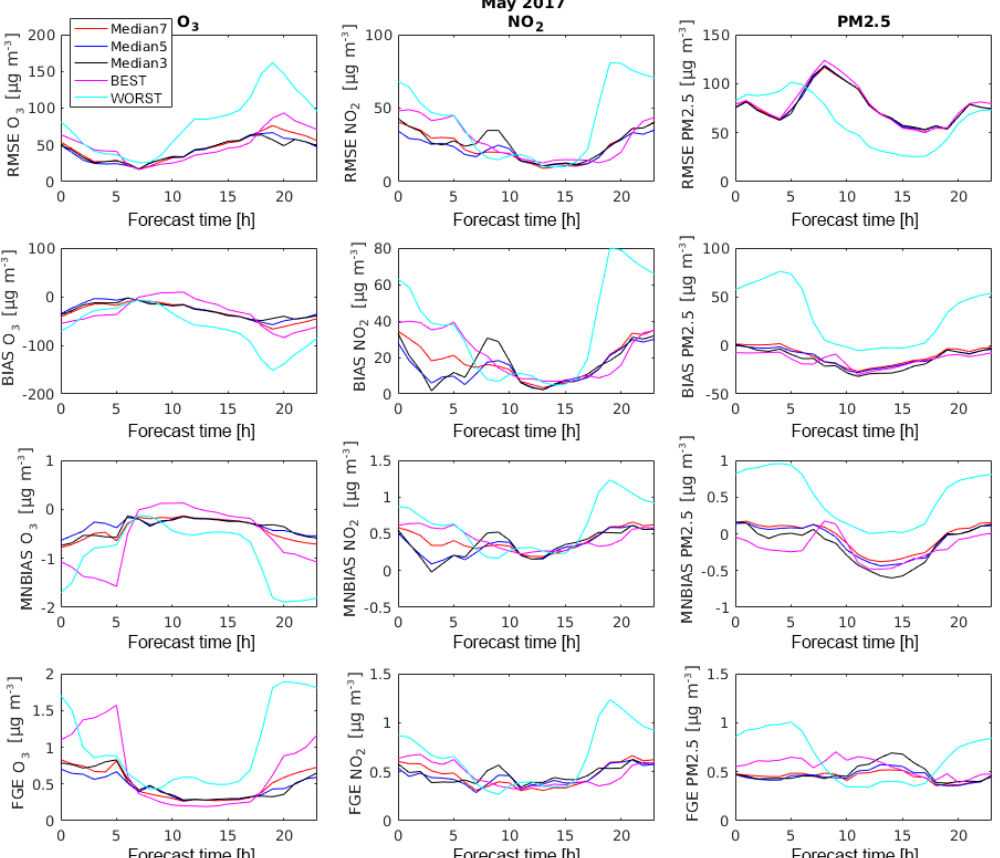
Figure 9. RMSE, BIAS, MNBIAS, and FGE of O 3 , NO 2 , and PM 2 . 5 over the forecasting time (time of the day) for the Median7, Median5, Median3, and the best and worst model.